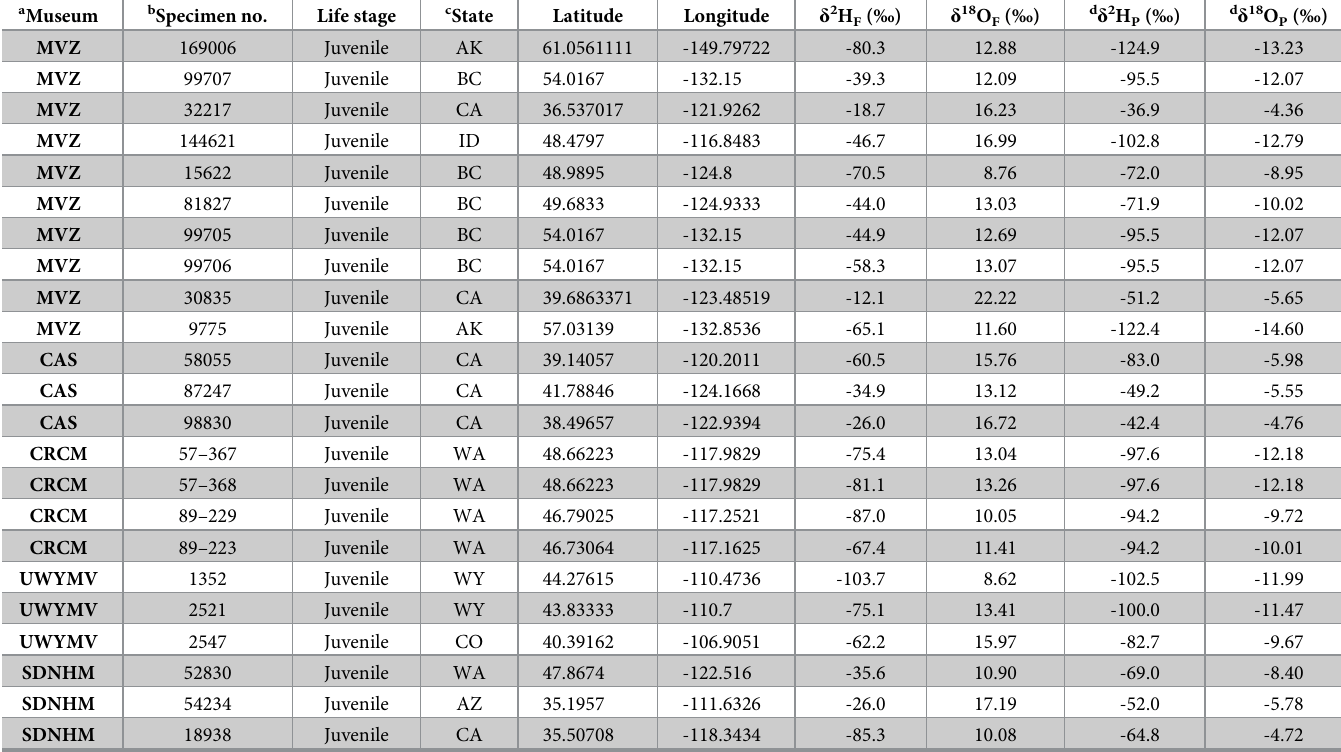
Table 1. Hydrogen and oxygen stable isotope composition of feathers of museum juvenile Sharp-shinned Hawk ( Accipiter striatus ) specimens ( δ 2 H F and δ 18 O F val- ues (‰)), and IsoMAP isoscape modeled stable hydrogen and oxygen isotope composition of precipitation ( δ 2 H P and δ 18 O P values (‰)) of known natal